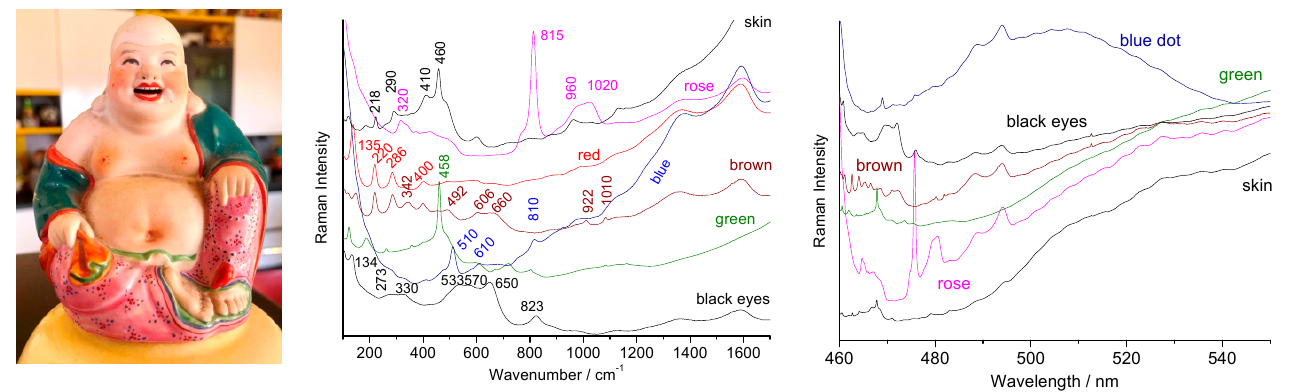
Figure 8. Representative Raman spectra recorded on a Chinese porcelain Buddha figure from the 1960s; right full range spectra plotted in absolute scale (nm); a zoom of the spectra is given on the left (wavenumber scale); colored area examined are given.